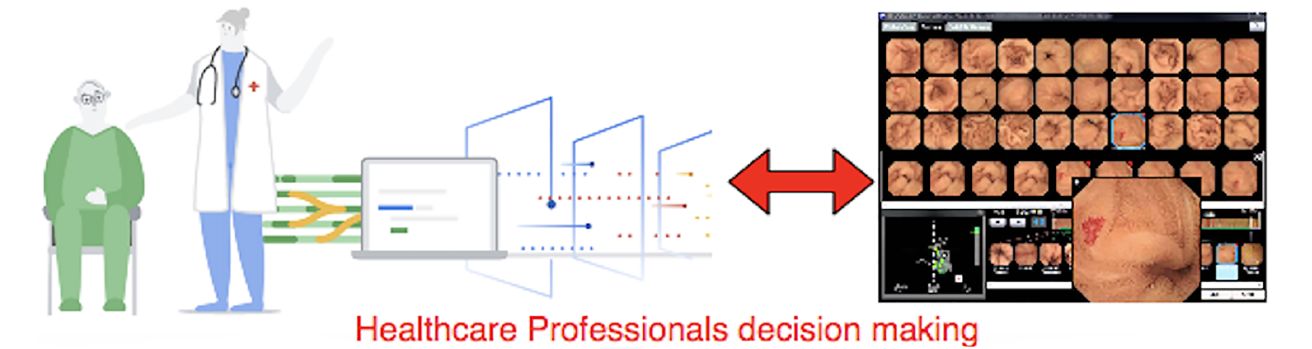
Figure 1. XAI helping medical professionals in